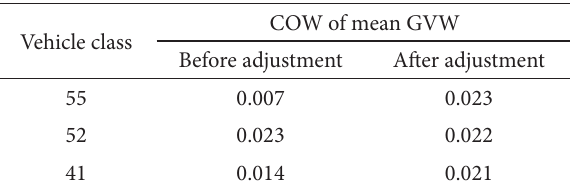
Table 3. Minimum, average and maximum GVW for Class 55, 52, 41 vehicles before and after data cleaning Vehicle class